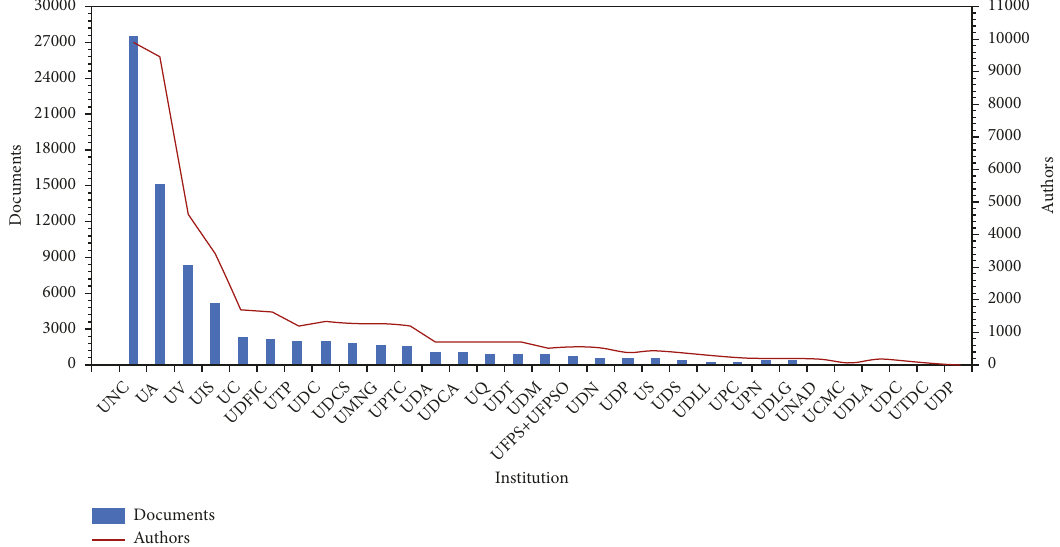
Figure 3: Colombian institutions by the number of authors and documents (scientific